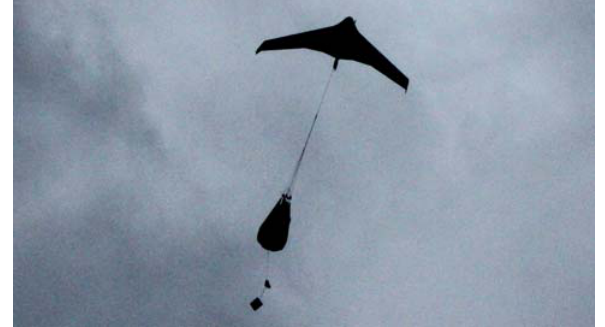
Figure 4: The C-Astral Bramor UAV during the initial deployment of its landing